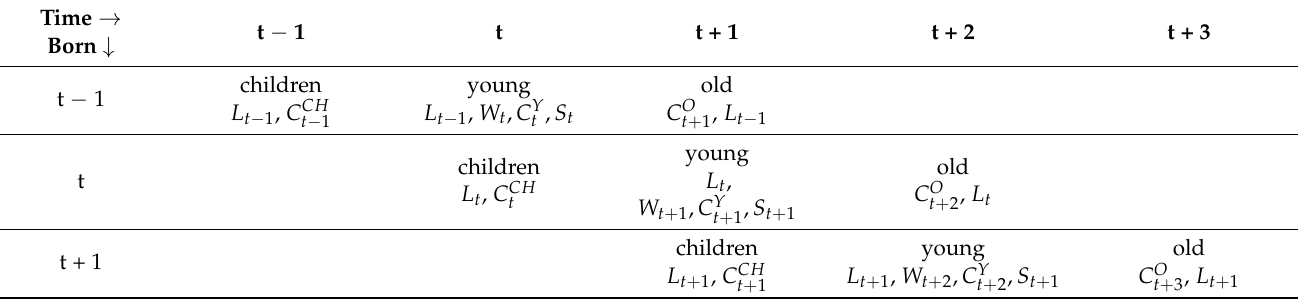
Table A1. The most basic notations as a function of